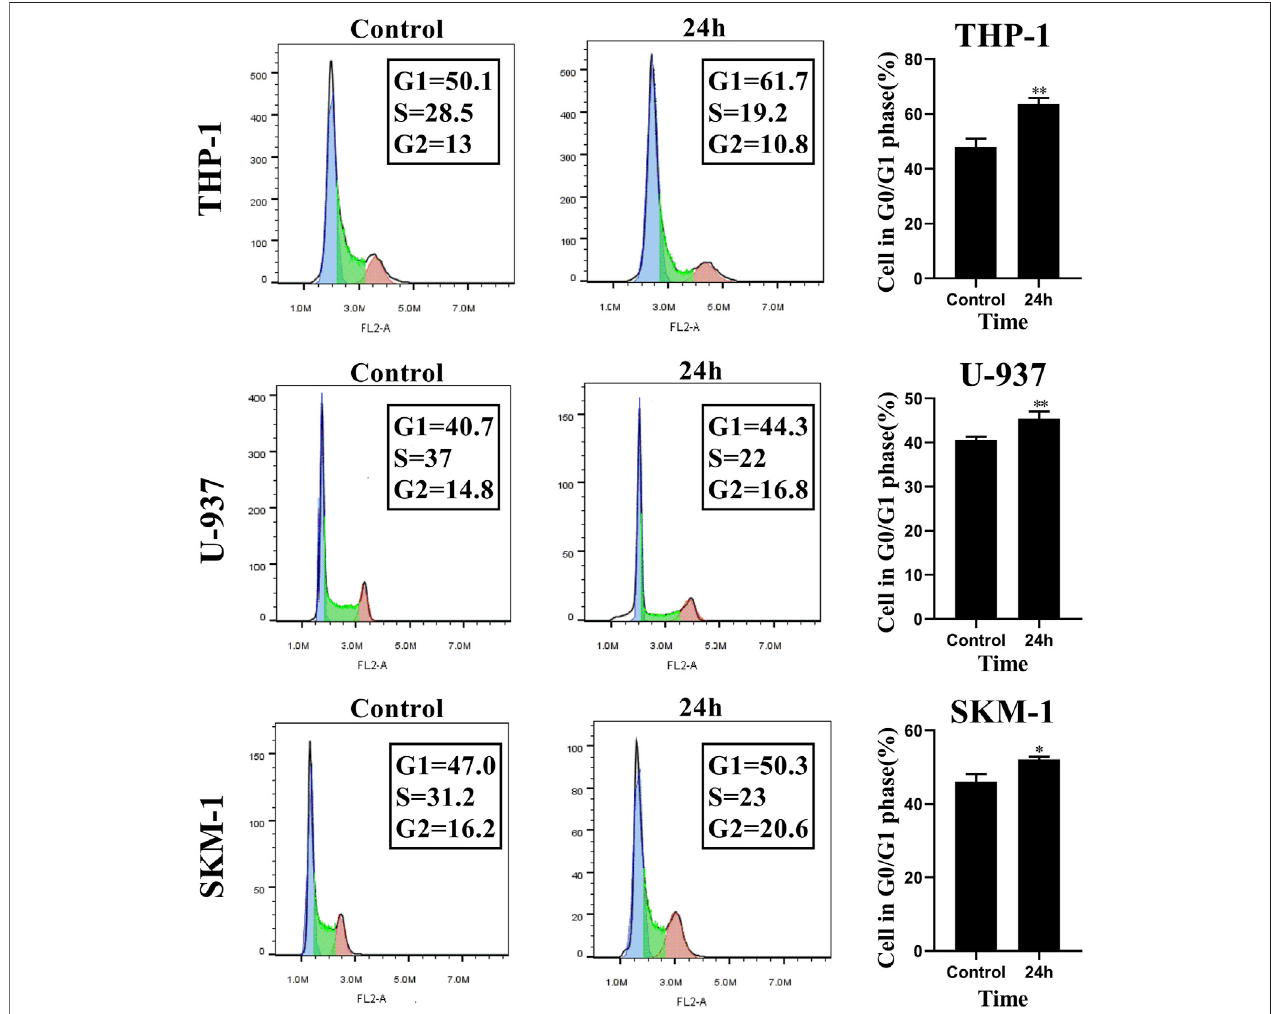
FIGURE 3 | Honokiol arrests cell cycle of THP-1, U-937 and SKM-1 cells at G0/G1 Phases. The cells were incubated with the speci fi ed concentration of honokiol (THP-1: 20 μ M; U-937: 35 μ M; SKM-1: 30 μ M) and then analyzed using fl ow cytometry with PI staining. Statistical analysis of G0/G1 phase cells was shown as a bar graph (*, p < 0.05, **, p < 0.01, compared to the control group). These data are from three separate